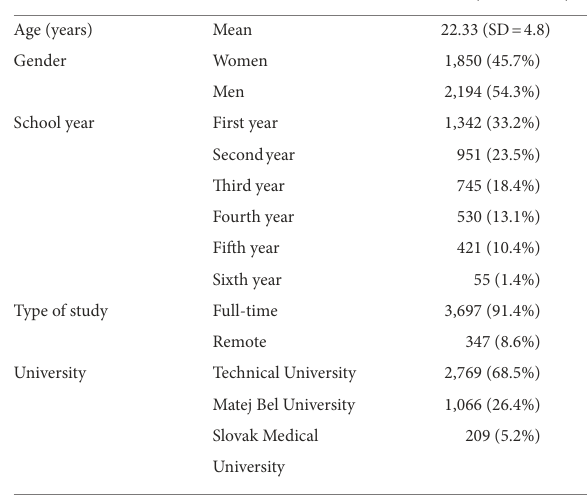
FIGURE 1 Flow diagram of the